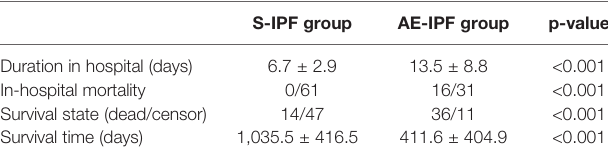
TABLE 4 | Clinical outcomes in patients with S-IPF and AE-IPF.